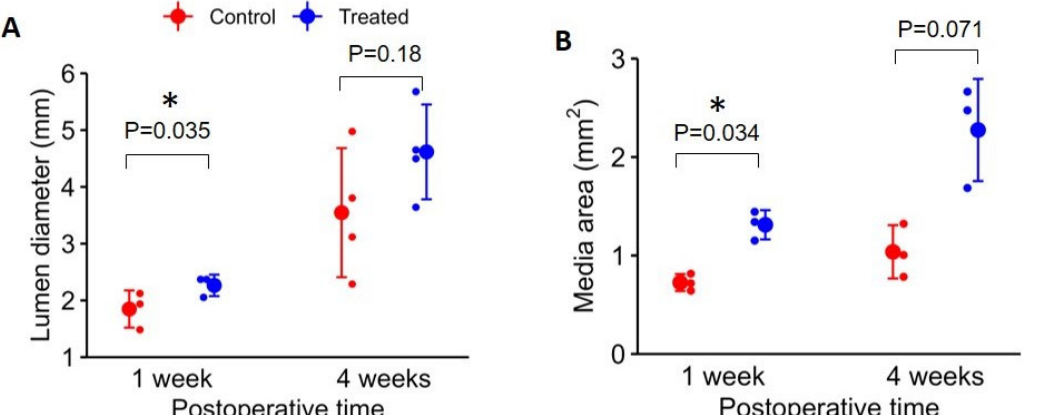
Figure 2. Histomorphometric Analysis of the Proximal Outflow Vein Sections from the Sheep AVF Studies. The illustrated histomorphometric analysis was performed on vein sections proximal to the anastomosis. ( A ) The size of the luminal diameter at 1 week and 4 weeks following surgery. The luminal diameter of the treated veins (blue dots) 1 week following surgery was significantly larger ( p = 0.035) compared with control veins (red dots). The asterisks (*) in the graphs denote where statistically significant differences have been observed. By the 4th week following surgery, the difference was not statistically significant. ( B ) The corresponding media area of the same veins was also different at 1 week, the treated veins (blue dots) having a significantly ( p = 0.034) thicker venous wall. This difference was not statistically significant by the 4th week. At 4 weeks, there were only three data points of media area because the artifacts in histological processing interfered with accurate quantification of the media area of one